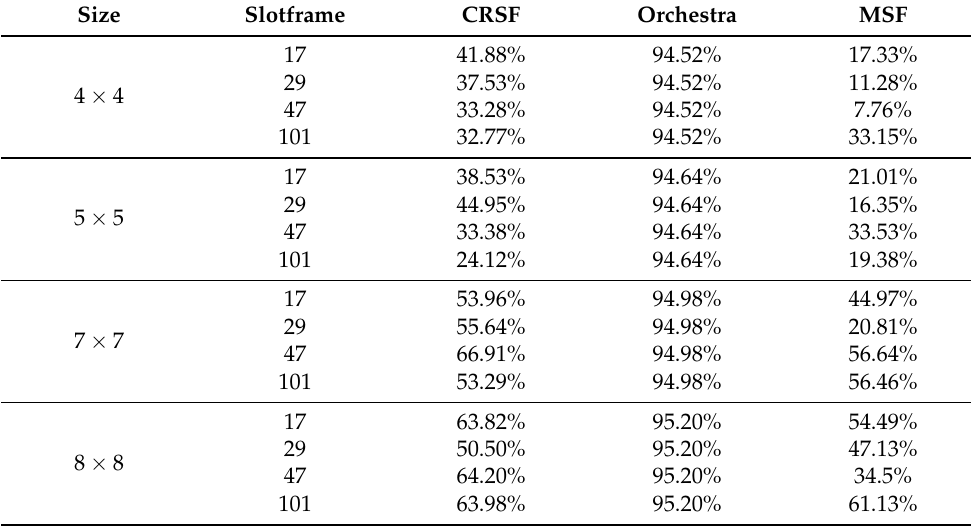
Table A7. Results for the RDC with a burst traffic